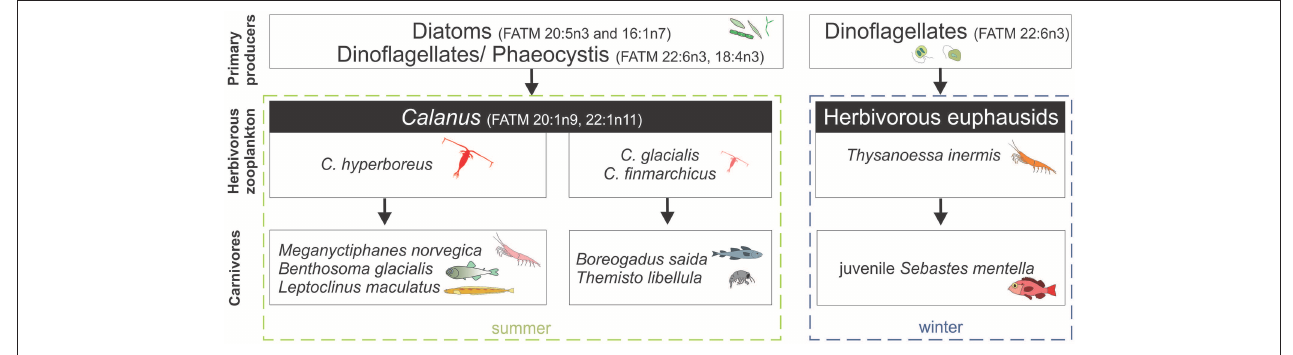
FIGURE 6 | Simplified schematic of the main pelagic food web pathways in summer 2016 and winters 2016-2017 based on the FATM